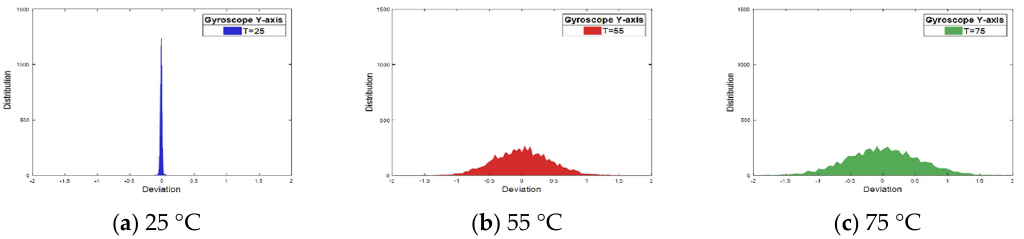
the largest deviation value was revealed at 75 ◦ C among all experimental deviation values.